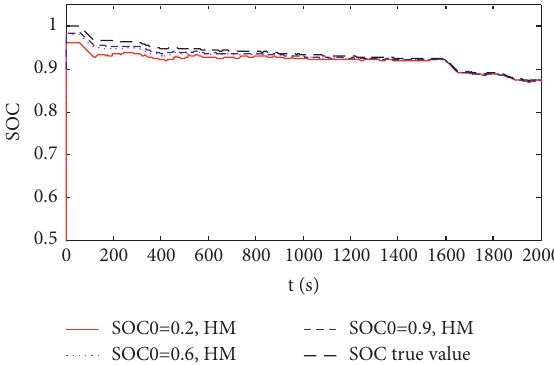
Figure 6: The convergence speed of HM under different SOC